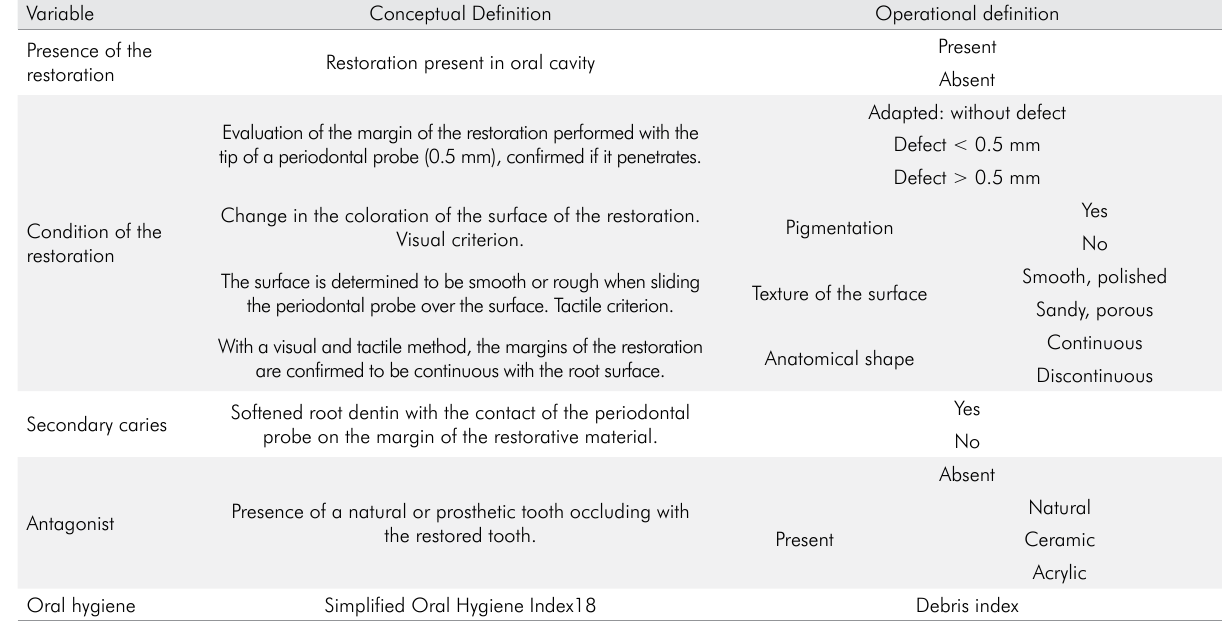
Table 1. Six-month assessment criteria of the restorations.